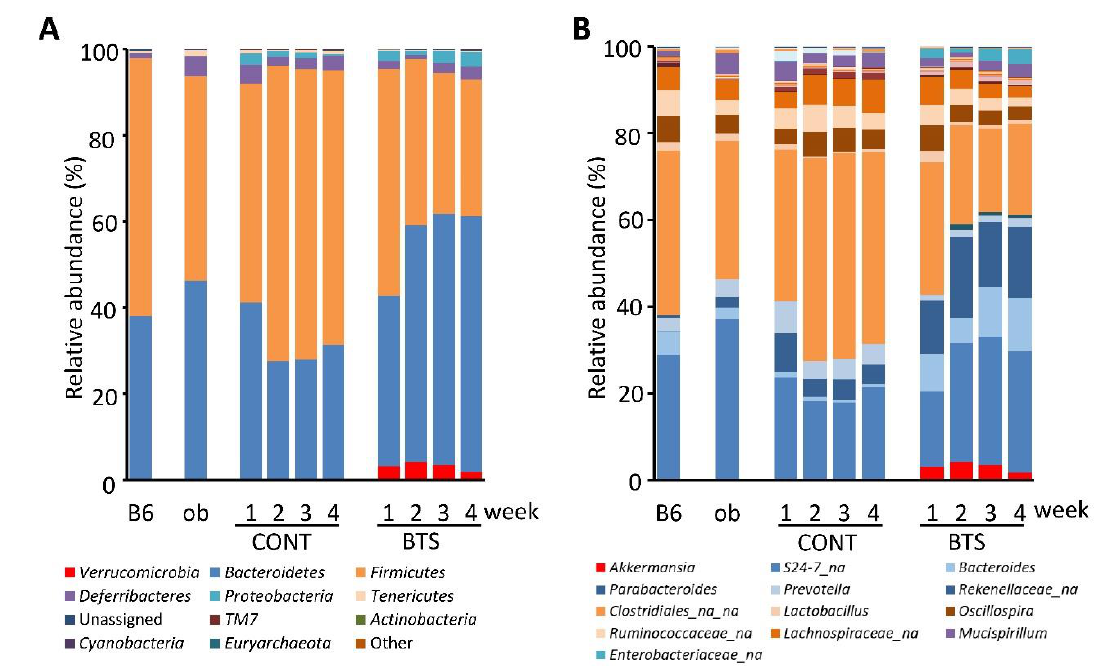
Figure 4. Microbiota composition in stool samples of mice fed a diet with or without BTS. Stools were collected weekly from mice fed with or without 5% (w / w) BTS. Relative abundance of gut microbiota was determined by 16S metagenome sequence analysis. Average relative abundance at each sampling point is shown as bar charts of phylum ( A ) and genus ( B ) levels ( n = 6). B6, C57BL / 6J mice (seven-week-old); ob, ob / ob mice (seven-week-old); CONT, ob / ob mice fed a standard diet; BTS, ob / ob mice fed a standard diet with 5%